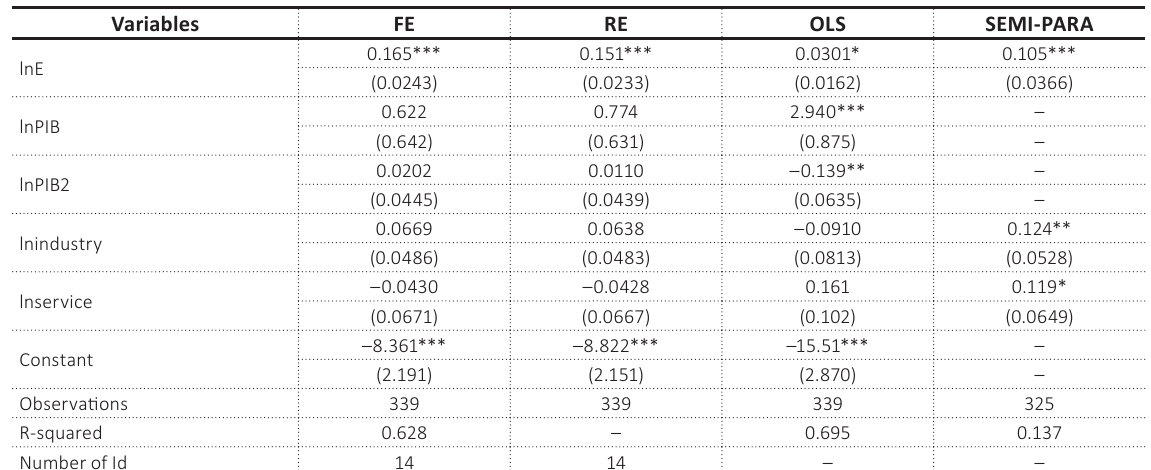
Table 4. Estimates with CO2 emissions